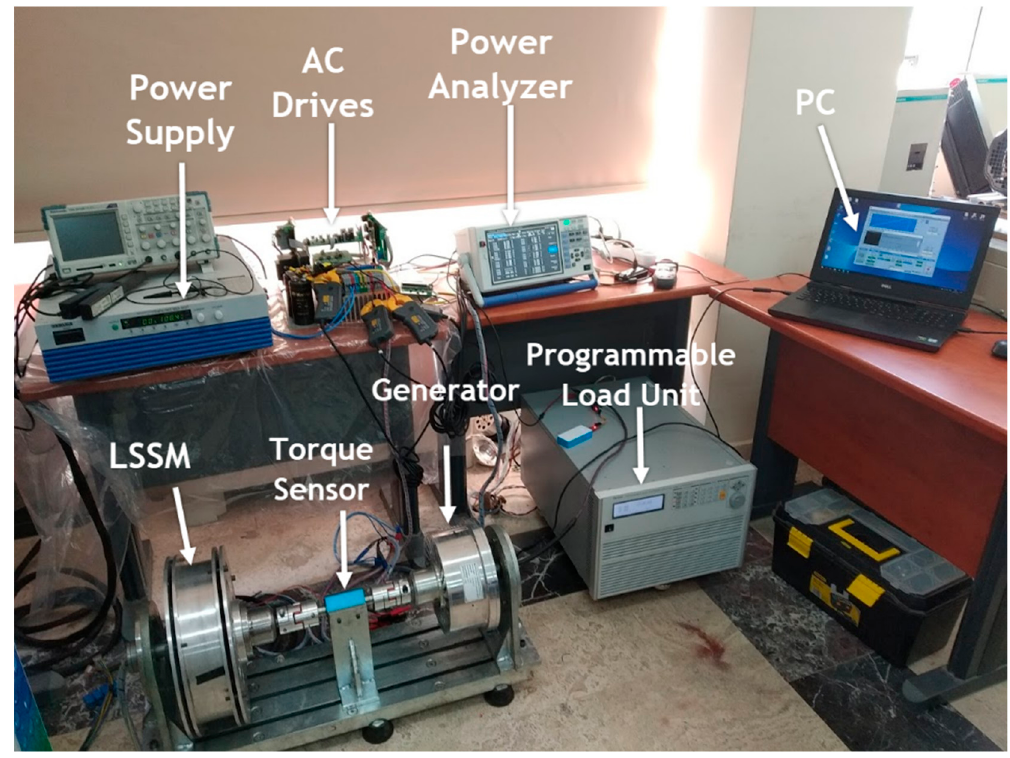
Figure 9. Experimental setup.